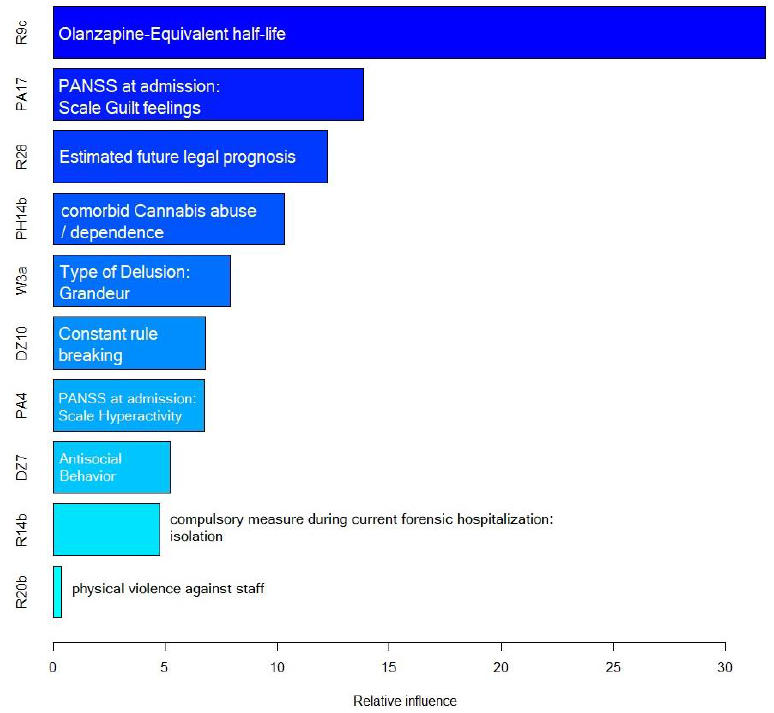
Figure 2. Variable importance Acc. to their relative influence in the final